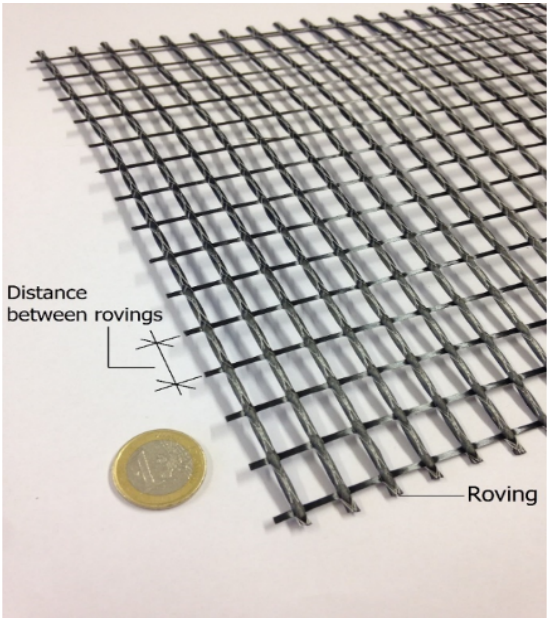
Figure 2. Textile reinforcement made of carbon rov-